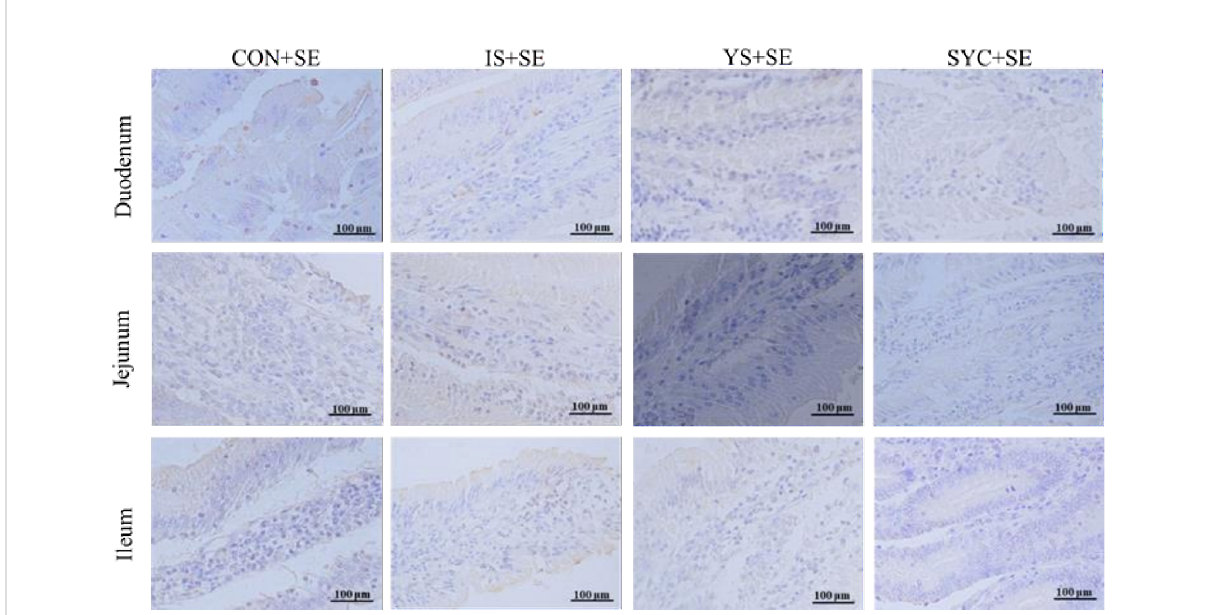
FIGURE 5 Effects of dietary supplementation with different Se sources on the small intestine immunoexpression of CD4 of laying hens challenged with S. Enteritidis. CON, basal diet; IS, sodium selenite; YS, yeast selenium; SYC, selenium-enriched yeast culture; SE, challenged with S. Enteritidis . Immunohistochemistry; total magni fi cation